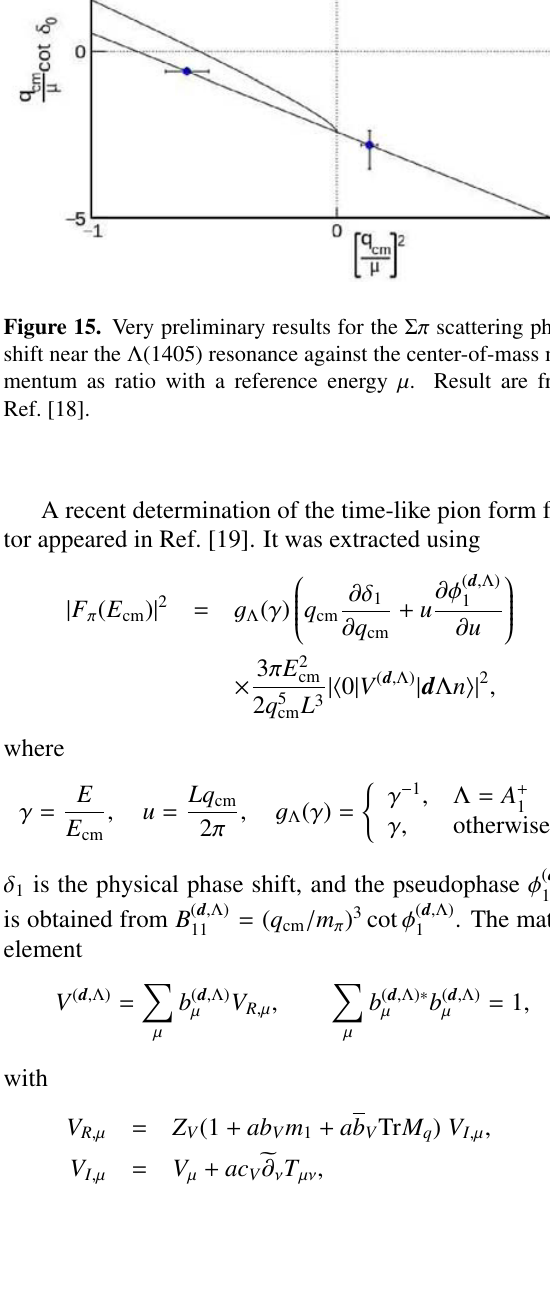
Figure 16. Timelike pion form factor | F π | again center-of-mass energy over pion mass E cm / m π using the CLS J303 ensemble on a 64 3 × 192 lattice with spacing a = 0 . 050 fm and m π = 260 MeV. The curve is a fit with a thrice-subtracted dispersion relation. Results are from Ref. [19]. This shows the feasibility of future calculations of baryon form